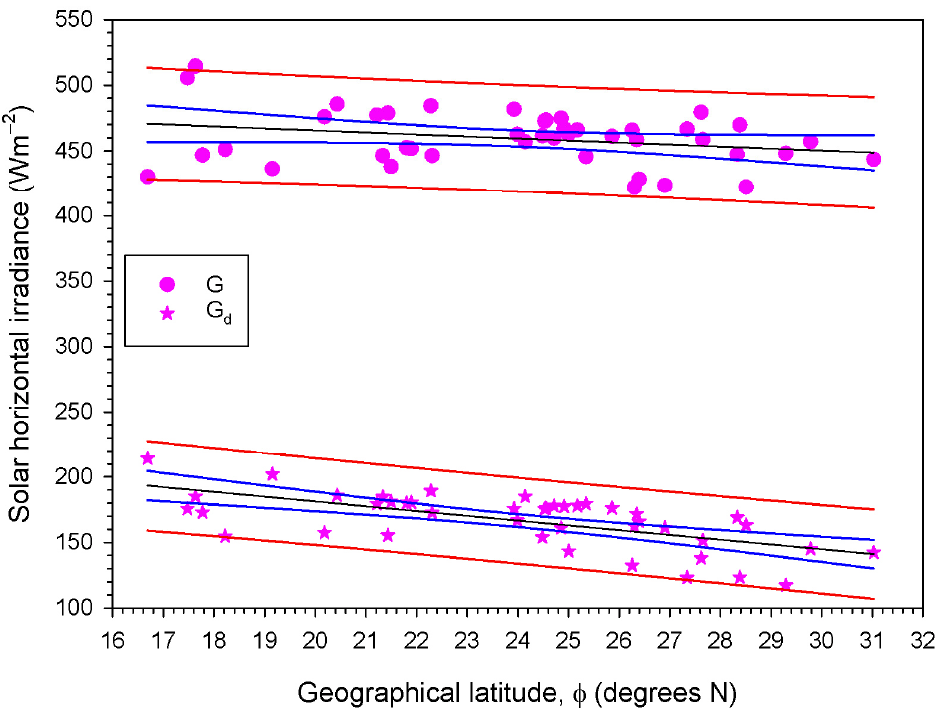
Figure 8. Scatter plot of the annual mean values of G (circles) and G d (stars) for the 43 sites as a function of their geographical latitude, ϕ , under all-sky conditions in Saudi Arabia for the period 2013–2021. The black solid lines are linear fits to all data points with equations G = − 1.5431 ϕ + 496.4431, with RMSE = 19.4784 Wm − 2 , MAE = 15.9444 Wm − 2 , d = 0.2430, r = 0.2725, and R 2 = 0.0743; and G d = − 3.6488 ϕ + 254.2412 with RMSE = 15.6541 Wm − 2 , MAE = 12.9758 Wm − 2 , d = 0.7350, r = 0.6402, and R 2 = 0.4098. The blue bands represent the ±95% con fi dence intervals, and the red ones represent the ±95% prediction intervals. The plot was made with the SYSTAT’s SigmaPlot 14.0.0.124 graphing software, and the statistical results were computed with the MICROSOFT’s Excel 2021 functions.